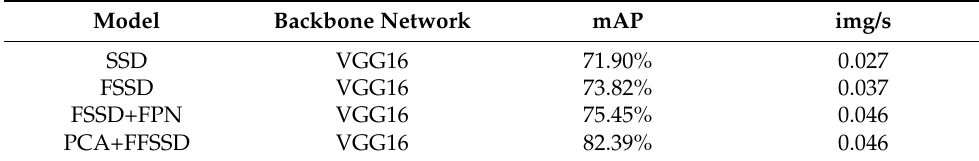
Table 1. Speed and Precision comparison on NVIDIA 1070.